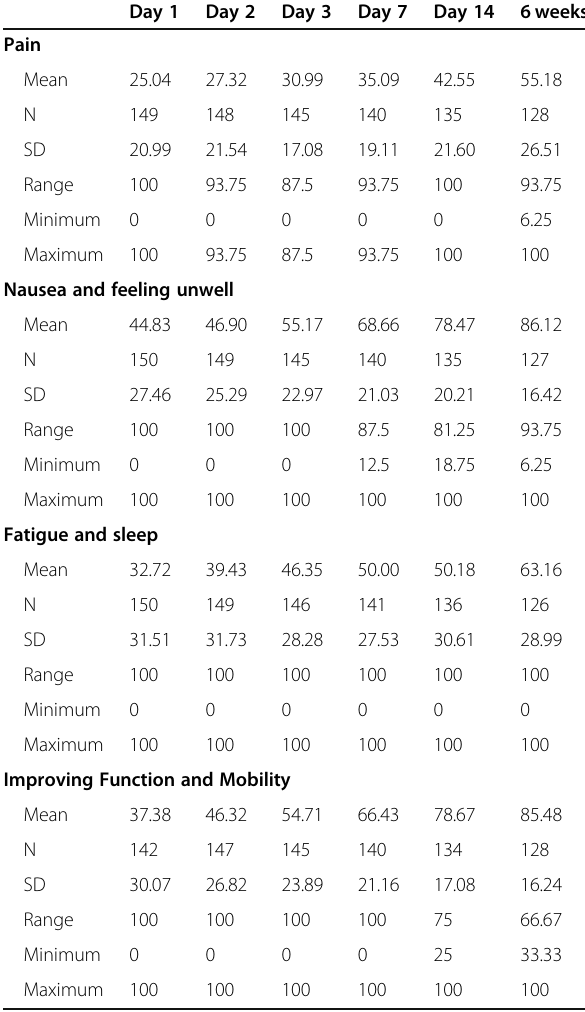
Table 12 Mean domain scores for